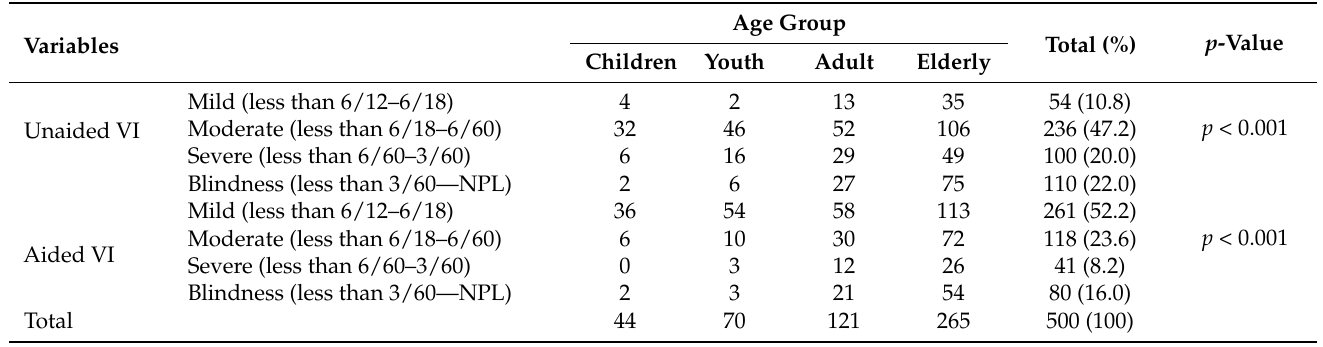
Table 3. Distribution of unaided and aided VI according to